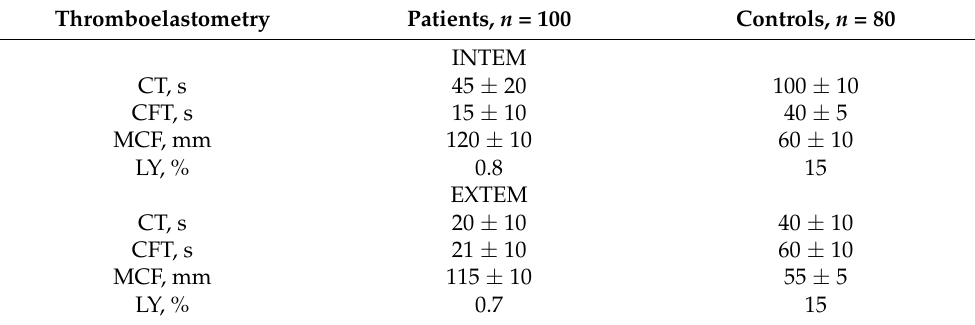
Table 3. ROTEM parameters of coronavirus disease 2019 (COVID-19)